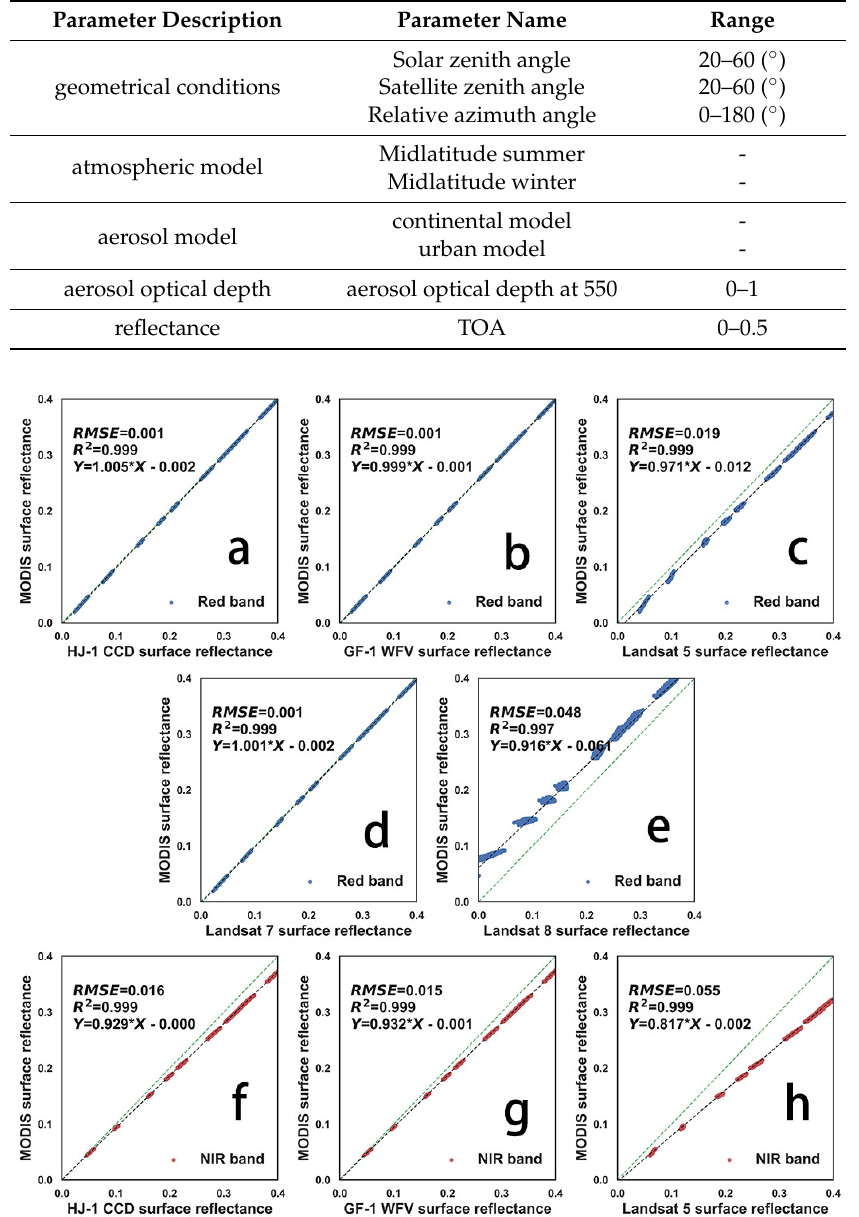
Table 2. List of variables required to 6S model and their ranges.